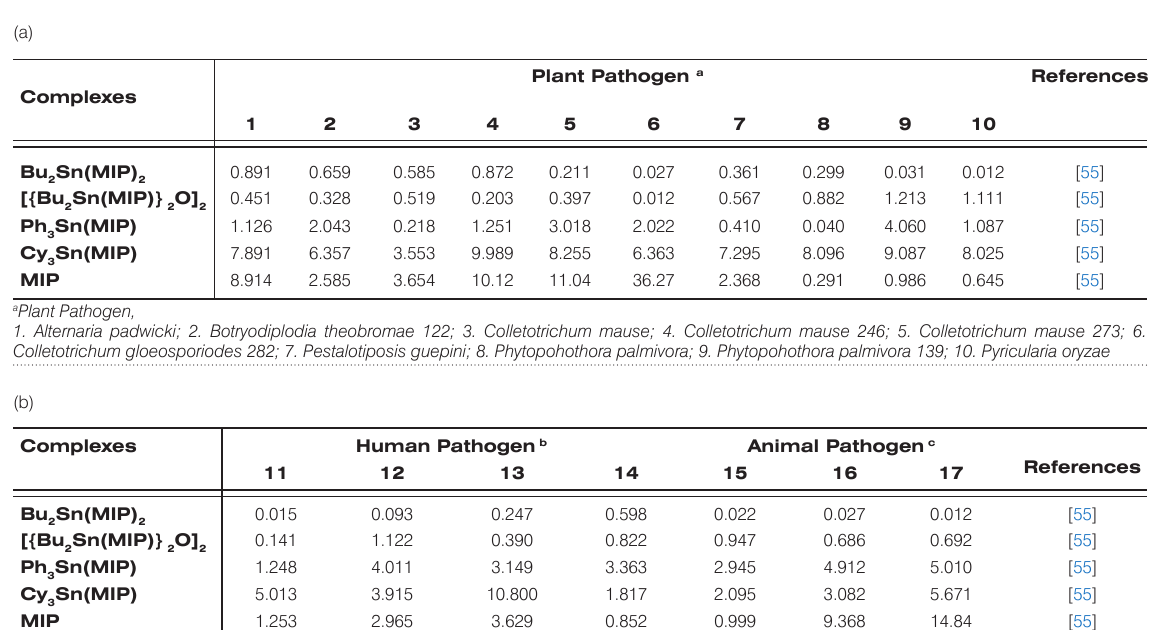
Table 5. Ed50 values for organotin(IV) carboxylates against selected plant-, human- and animal pathogenic fungi. (a) Complexes